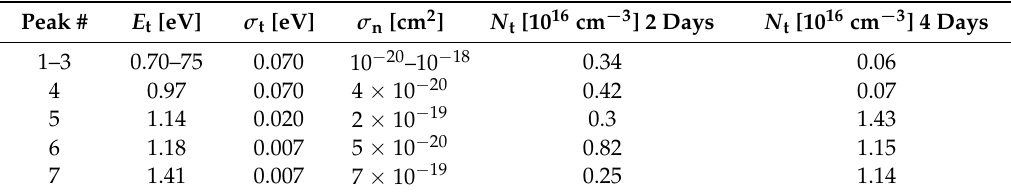
Table 1. Best fit trap parameters of the TSC measured after storage in humid air environment at room